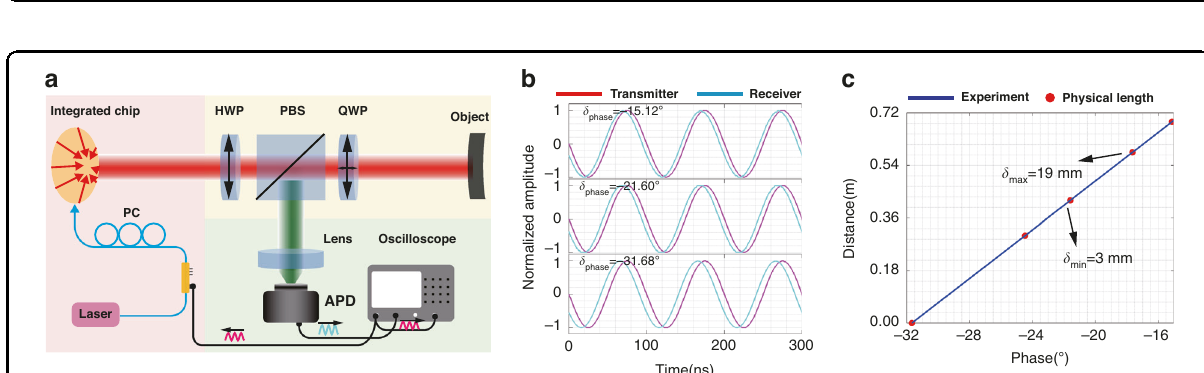
Fig. 5 The rotation speed measurement with obstacles. a The obstacles are cylindrical copper wire with a diameter of 1.18 mm and b 2 mm. They are 0.801 m away from the chip surface, and the rotation speed is 100 r/s. The power spectral line in each cell is measured under the light spot condition above the